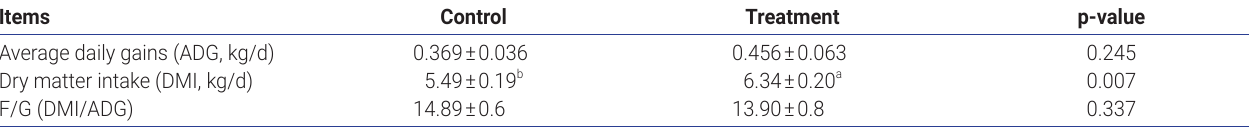
Table 3. Effects of photoperiod on growth performance of Jinjiang